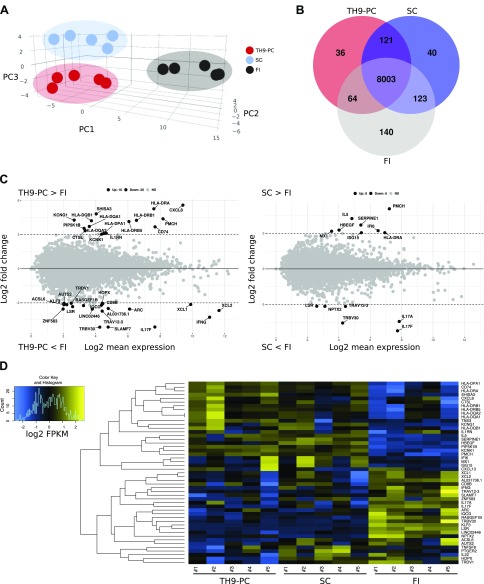
Culture conditions affect the transcriptional profile of skin T cells. RNA-seq analysis of Th9-PC, SC, and FI T cells of 5 healthy individuals. A) Principal component analysis of the 200 most significantly differentially regulated genes. Color-coded dots represent individual donors from indicated conditions. Principal components 1 and 2 accounted for 83.1% of the total variation. Color-coded ellipses mark clusters. B) Venn diagram of expressed genes [mean fragments/kb of transcript/106 (FPKM) >1] among each group. C) M (log ratio)/A (mean average)-plot (log2 fold change against log2 mean expression) showing differential gene expression between indicated conditions. Significantly regulated genes with more than 8-fold change were labeled with their respective gene symbol. D) Heatmap illustrating gene expression of differentially regulated genes selected from MA-plot analyses in 5 individuals per condition. Rows represent clustered genes and columns represent donors of each condition.